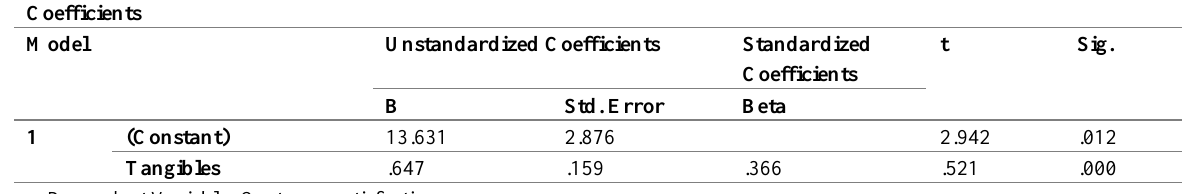
Table 17: Hypothesis Test Relationship between Tangibles and Customer Satisfaction